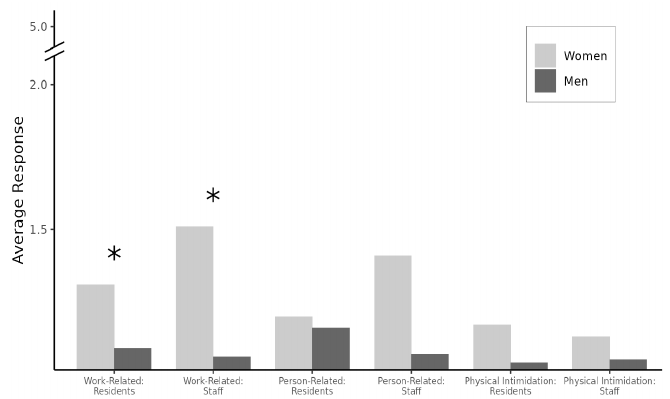
Figure. Horizontal violence (HV) presented as average survey response and broken down by gender and the three subcategories of HV: work-related, person-related, and physical intimidation. The self-reported frequency of violence is scored from 1 (never) to 5 (daily). Women experienced a higher incidence of work-related violence, both from other residents (P =.05) and from support staff members (P =.02). This was statistically significant in comparison to